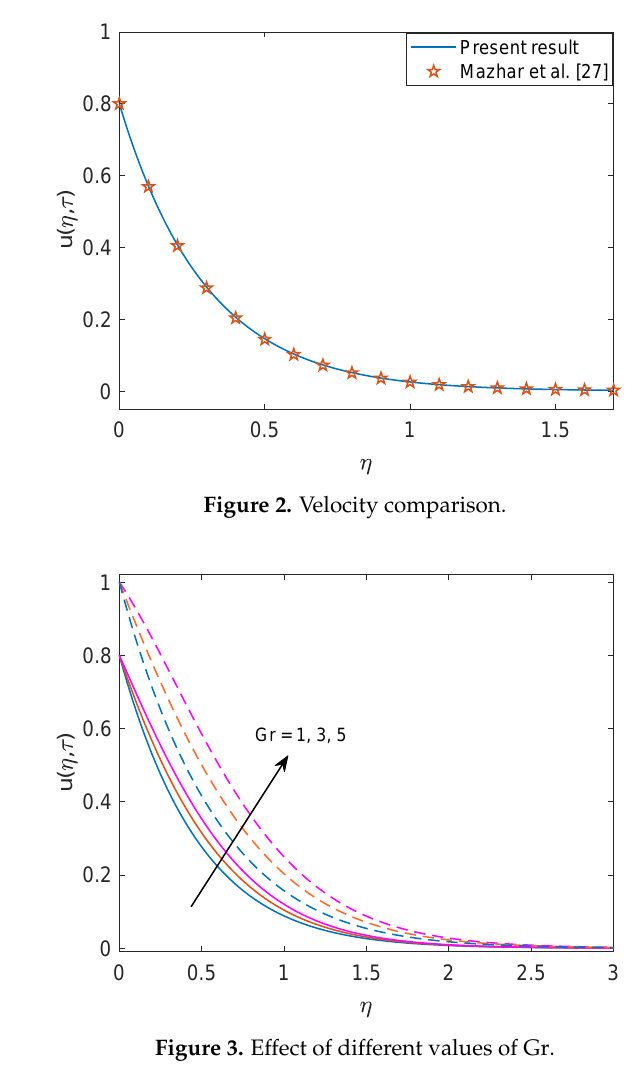
Figure 3. Effect of different values of Gr.